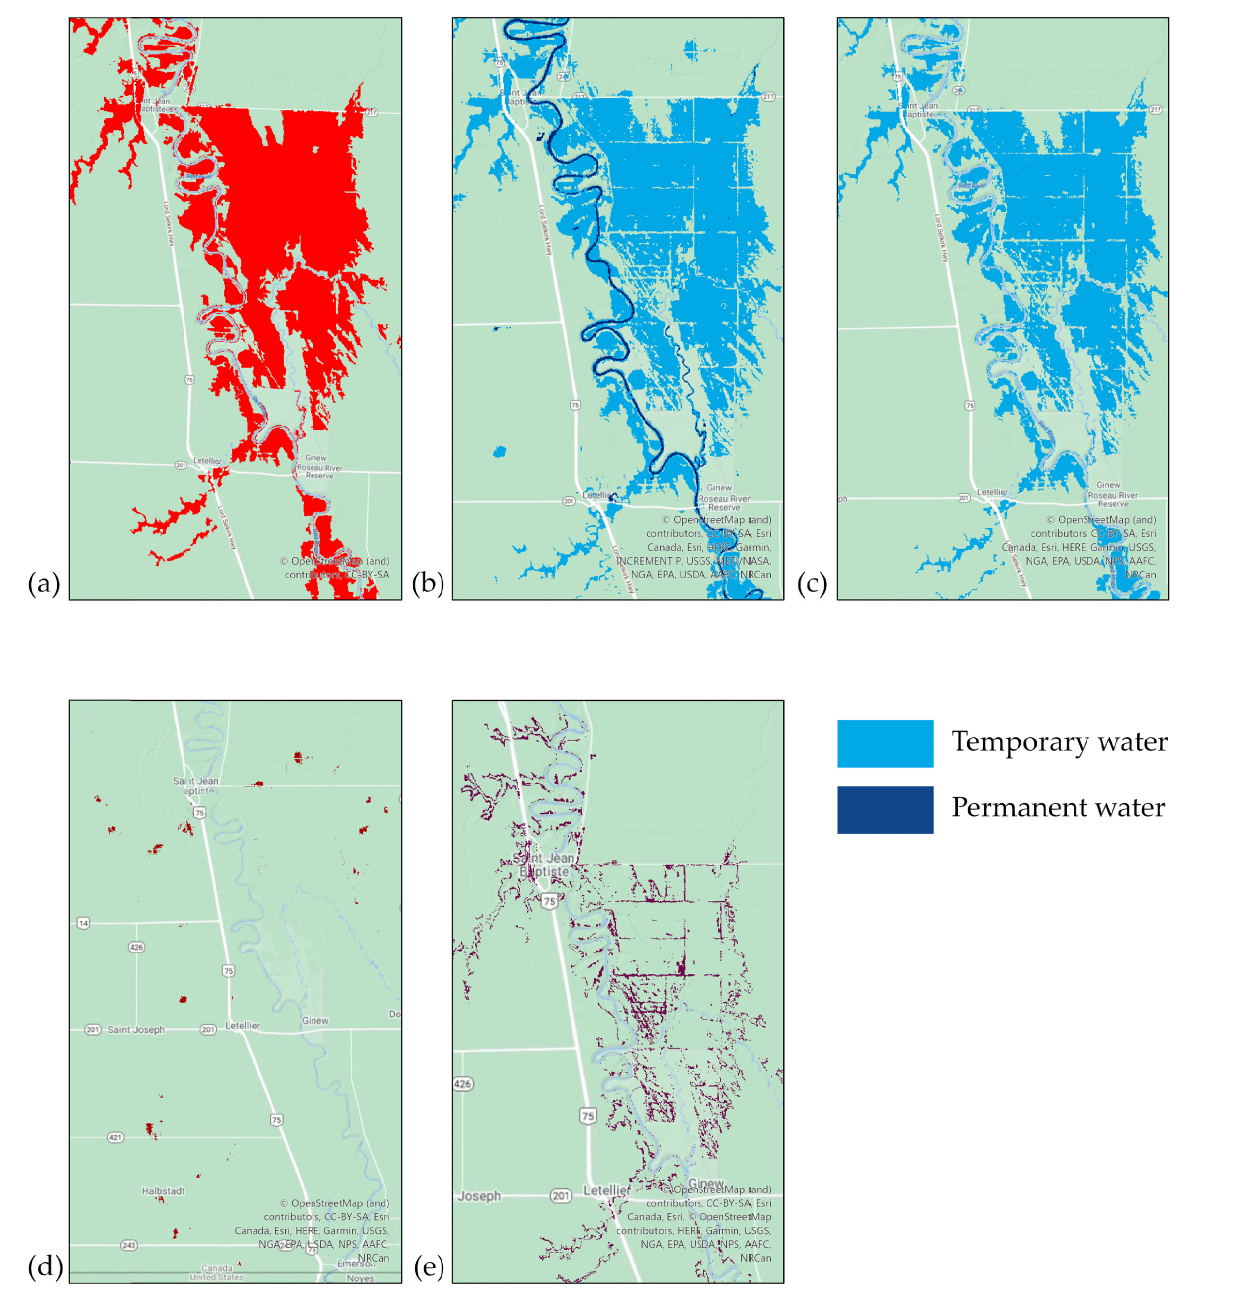
Figure 6. FMA inputs and outputs for 2019 Red River Flood ( a ) reference flood extent; ( b ) flood inundation extent mapped by FMA; ( c ) true positive; ( d ) false positive; ( e ) false